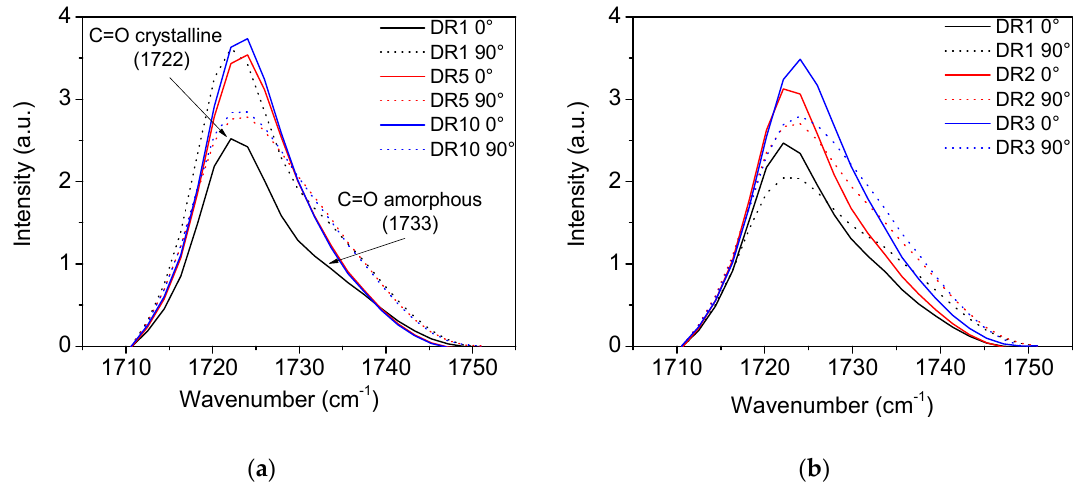
Figure A2. Magnification of FTIR spectra showing the carboxyl group. The solid lines correspond to measurements performed with polarizers at 0°, while the dotted lines correspond to measurements performed with polarizers at 90°. ( a ) PCL cooled with open chill rolls. ( b ) PCL cooled with closed chill rolls.